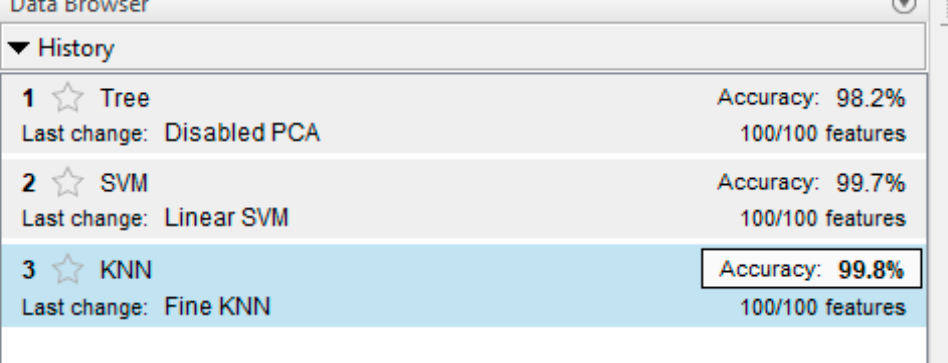
Figure 18. ANN-classifier learning result.